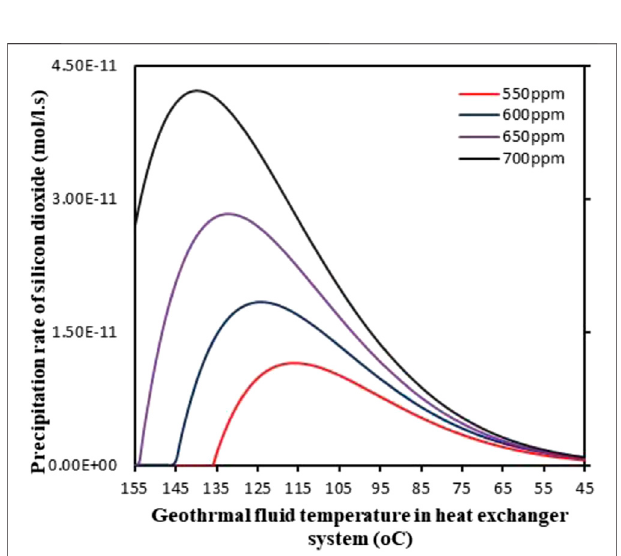
FIGURE 6 | Precipitation rate as a function of temperature in the heat exchanger system/geo-preheater for Scenario 3.